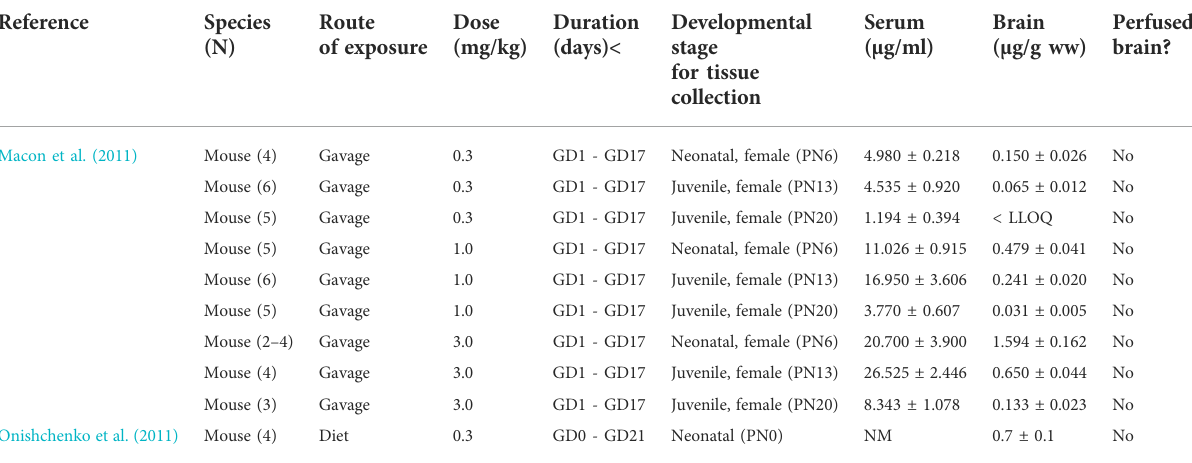
TABLE 2 Pregnant laboratory mice were exposed to per fl uorooctanoic acid (PFOA) daily through different exposure routes, doses, and durations as provided